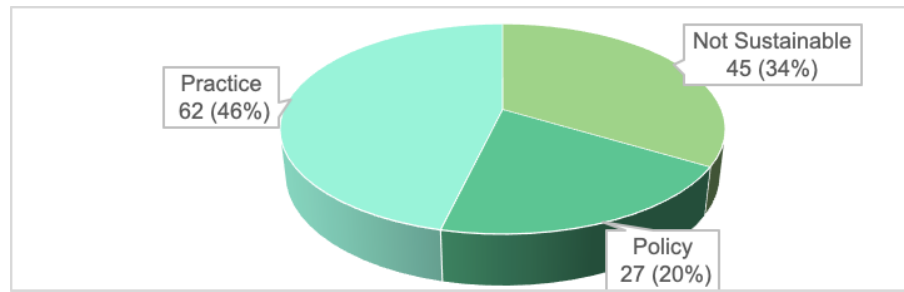
Figure 6. Sustainability of positive outcomes ( N = 134).